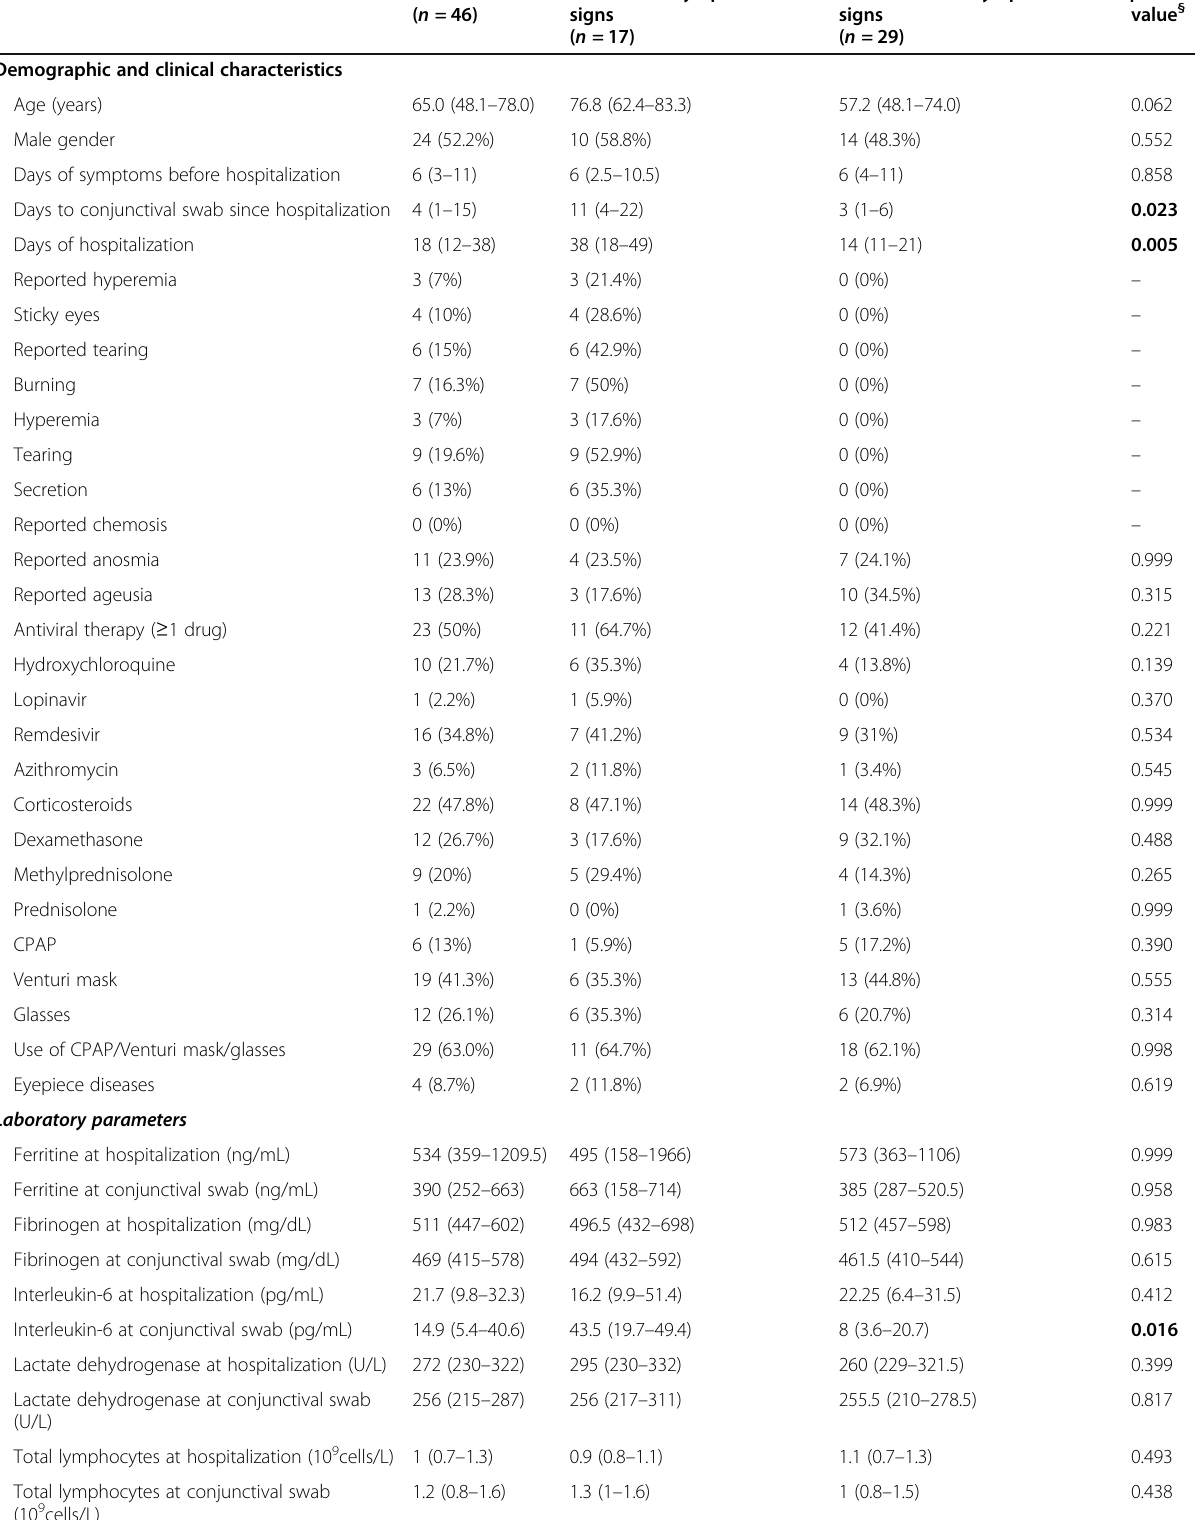
Table 1 Patients ’ characteristics according to the presence of ocular symptoms